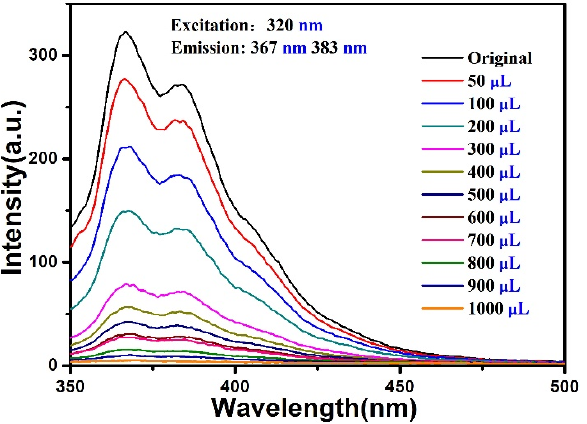
Figure 7. Fluorescence spectra of the compound with addition of Cu 2+ (5 × 10 − 3 M).